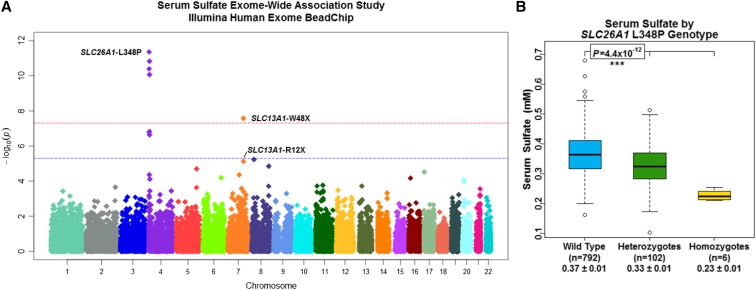
ExWAS of serum sulfate enables discovery of SLC26A1 L348P. (A) Manhattan plot depicting association results (plotted as –log10
P-value on y-axis) of individual single nucleotide polymorphisms distributed across the 22 autosomes (x-axis) from the serum sulfate ExWAS performed using the Illumina Human Exome BeadChip platform (n = 900). Red horizontal dotted line indicates P = 5.0 × 10−8. Blue horizontal dotted line indicates P = 5.0 × 10−6. (B) Serum sulfate by SLC26A1 L348P genotype. Box and whisker plots: box represents 2nd and 3rd quartiles (IQR, interquartile range); horizontal band represents median value; whiskers represent 1st and 4th quartiles; ends of whiskers represent minimum and maximum values, excluding outliers; open circles represent outliers (data point >1.5*IQR below the 1st quartile or above the 3rd quartile). Association analyses between genotypes and serum sulfate were conducted using a regression-based method that models variation of the trait of interest as a function of measured covariates, measured genotypes, and a polygenic component that accounts for phenotypic correlation due to relatedness.